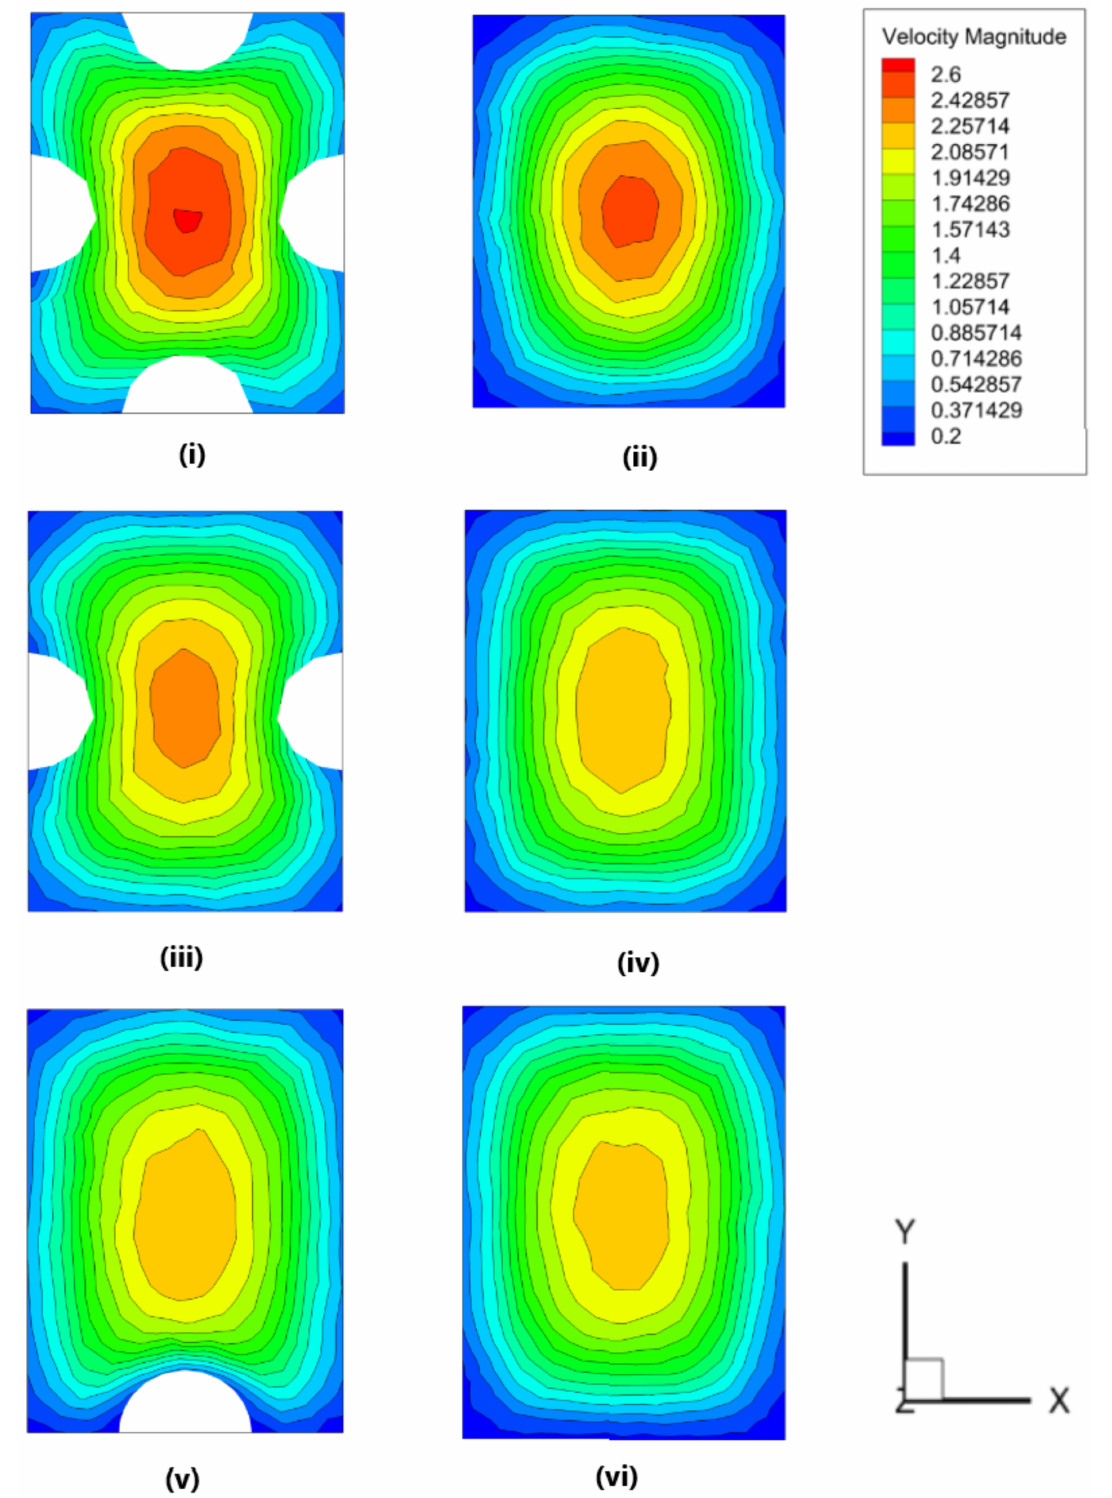
Figure 11. Velocity contours for different MCHS configurations in the X-Z plane at two different distances along the z-axis: ( i ) MC-SAWR (z = 5 mm), ( ii ) MC-SAWR (z = 5.34 mm), ( iii ) MC-SSWR (z = 5 mm), ( iv ) MC-SSWR (z = 5.34 mm), ( v ) MC-SBWR (z = 5 mm), ( vi ) MC-SBWR (z = 5.34